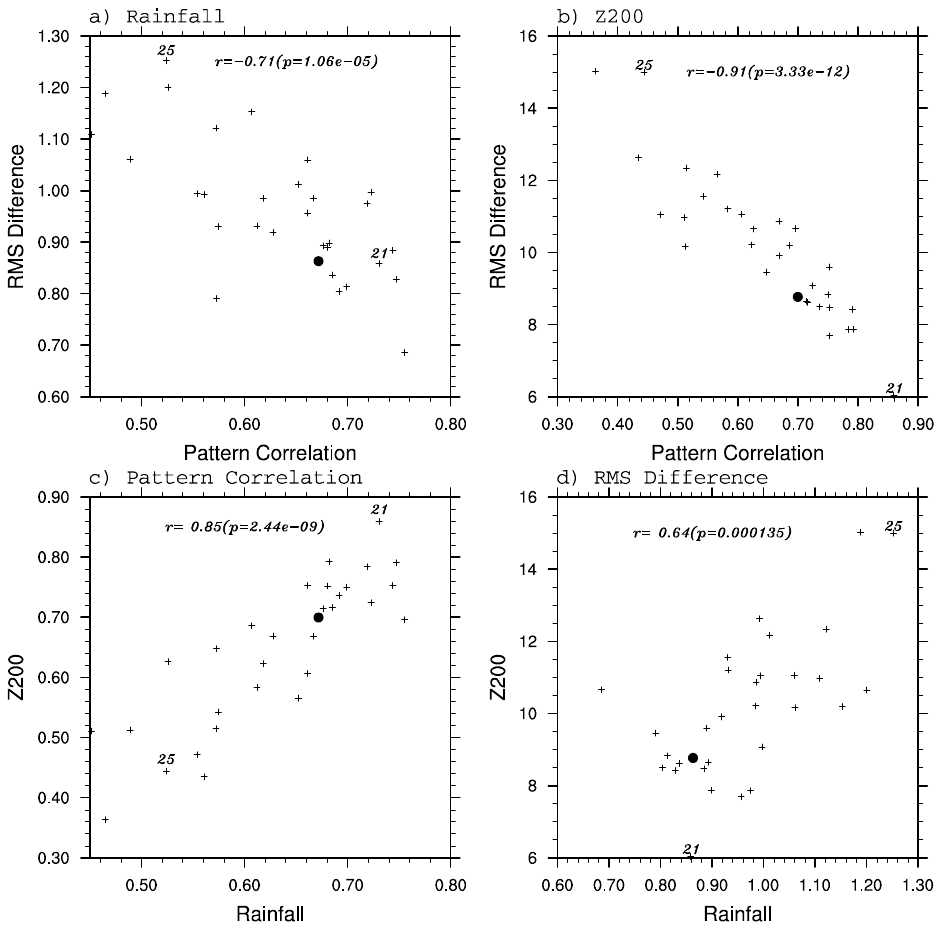
Figure 3. ( a ) Scatter plot between pattern correlation and RMS difference of rainfall dipole for each member against observations. ( b ) Same as (a) but for Z200. ( c ) Scatter plot of pattern correlations between rainfall and Z200 for each member against observations. ( d ) Same as ( c ) but for RMS differences. Black dots denote the ensemble mean. The correlation and corresponding p -value are shown in each panel. Runs 21 and 25 are marked for following